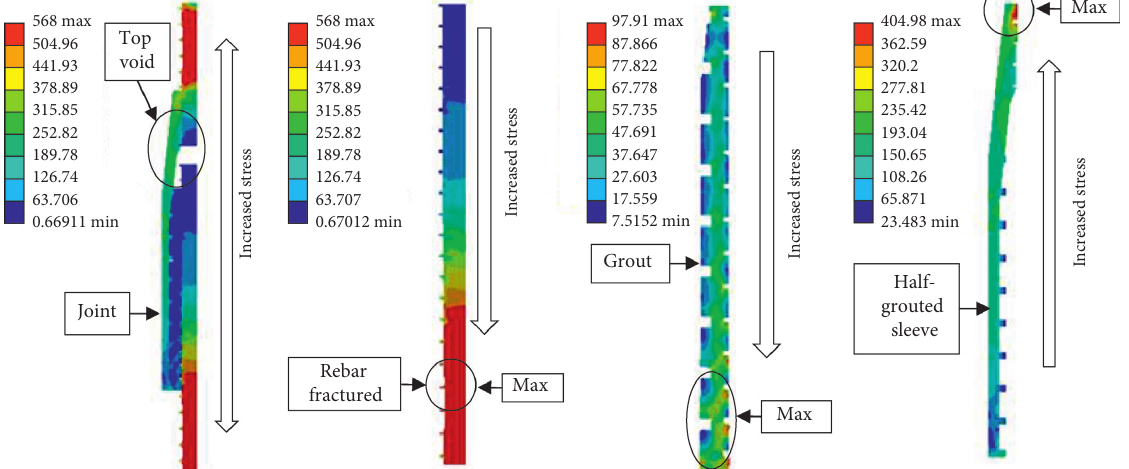
Figure 10: The finite element stimulation stress distribution diagram of the vertical insufficient grouting height specimen (104mm: 6.5d, unit: MPa).